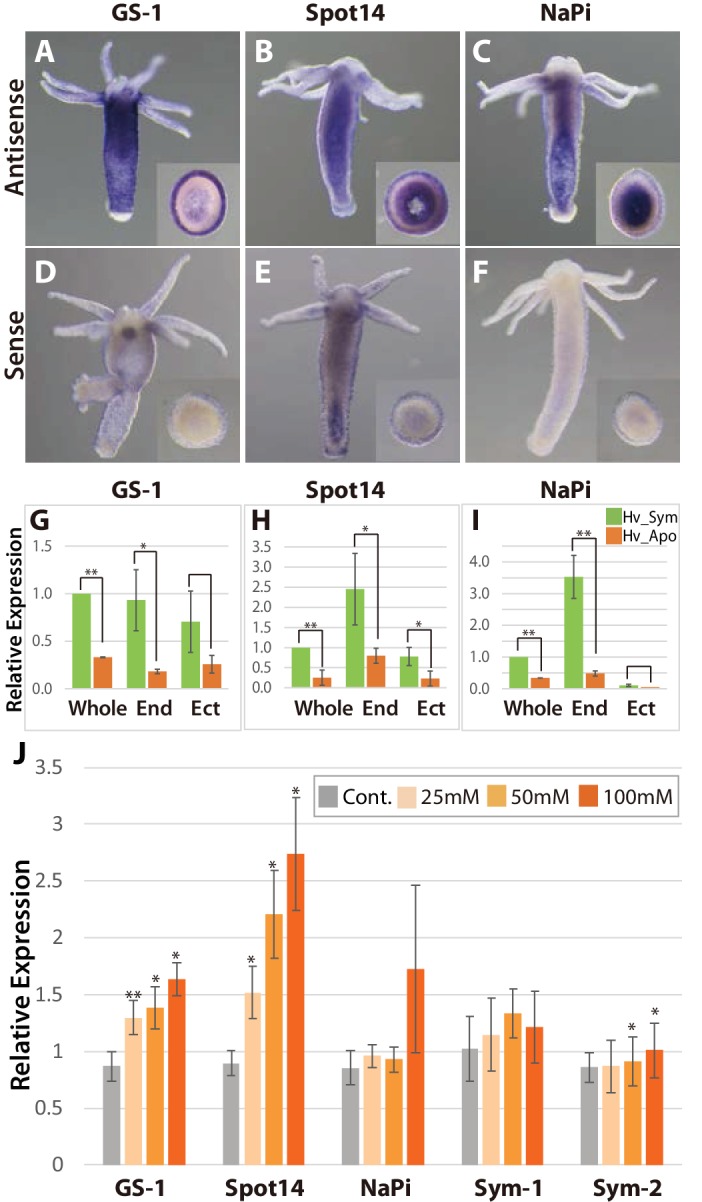
Spatial expression patterns of genes coding for glutamine synthetase, Spot 14 and Na/Pi-transporter.(A-F); Whole mount in situ hybridization using antisense (A–C) and sense probes (D-F; negative controls) for glutamine synthetase-1 (GS-1; left), Spot 14 (center) and Na/Pi-transporter (NaPi; right). Inserts show cross sections of the polyp’s body. (G–I) Relative expression levels of whole animal (whole), isolated endoderm (End) and isolated ectoderm (Ect) tissue of Hv_Sym (green bars) and Hv_Apo (orange bars). For each biological replicate (n = 3) 10–20 hydra polyps were used for total RNA extraction of endodermal and ectodermal tissue. T-test was performed between Hv_Sym and Hv_apo. Pvalue, *<0.05, **<0.01. (J) Expression change of genes GS-1, Spot14, NaPi, Sym-1 and Sym-2 following exposure to 25, 50 and 100 mM maltose in Hv_Apo. For each biological replicate (n = 3) 50 hydra polyps were used for total RNA extraction The vertical axis shows log scale (log2) fold changes of relative expression level of maltose-treated over the untreated Hv_Apo control. T-test was performed between maltose-treated in each concentration and control (*: p value <0.05) and Kruskal-Wallis test (†: p value <0.05) in the series of 48 hr treatment were performed. Error bars indicate standard deviation.10.7554/eLife.35122.021Figure 3—source data 1.Expression change of genes GS-1, Spot14, NaPi, Sym-1 and Sym-2 following exposure to 25, 50 and 100 mM maltose in Hv_Apo examined by qPCR.